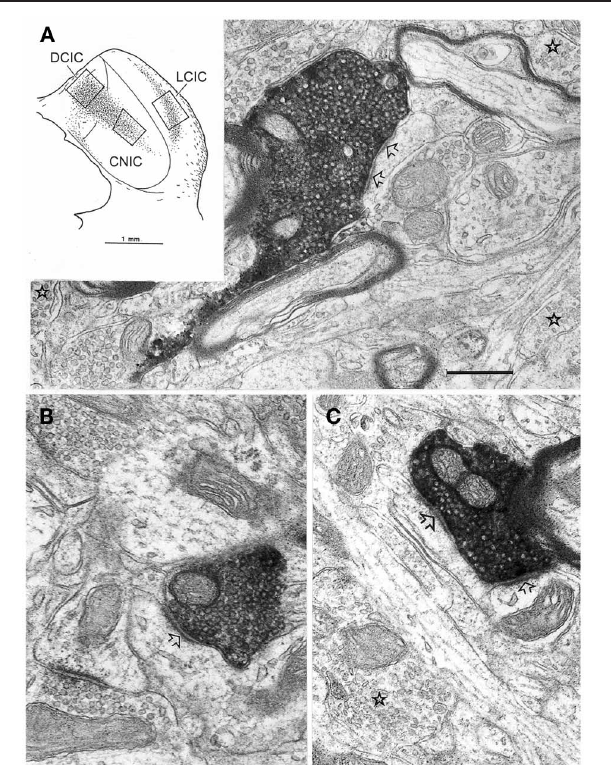
FIGURE 5 | Electron micrographs of labeled endings in the three main subdivisions of the IC after a large injection of biotinylated dextran amine was made in the ipsilateral primary auditory cortex in the rat. Labeled terminals in DCIC (A) , CNIC (B) , and LCIC (C) contain round vesicles and make asymmetric synaptic contacts (arrows). Unlabeled terminals with pleomorphic vesicles are also observed (stars). Inset in panel (A) shows the distribution of corticocollicular terminal fields and the areas (the box in each IC subdivision) that were used for electron microscopy. Calibration bar: 0.4 µ m. Modified with permission from Saldaña et al.